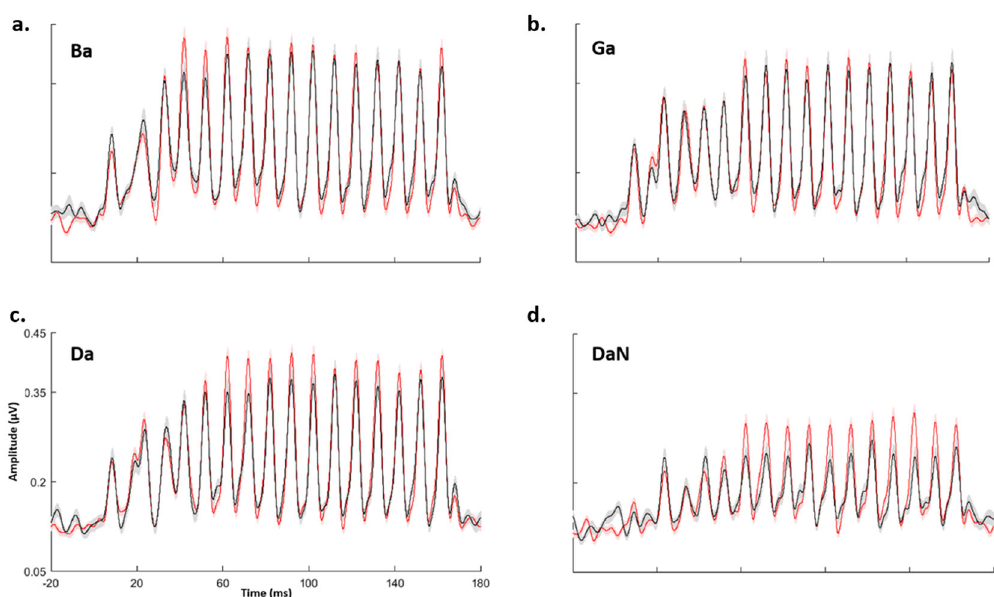
Fig. 2 Envelope response to the four speech stimuli compared between Non-synchronizers (black) and Synchronizers (red). Envelope responses were averaged across participants in the Non-Synchronizer group ( N = 37) and the Synchronizer group ( N = 63). The averages for each stimulus (( a ) Ba; ( b ) Ga; ( c ) Da; ( d ) DaN) were then plotted in amplitude versus time graph. Solid lines represent means and shaded lines represent ± 1 standard